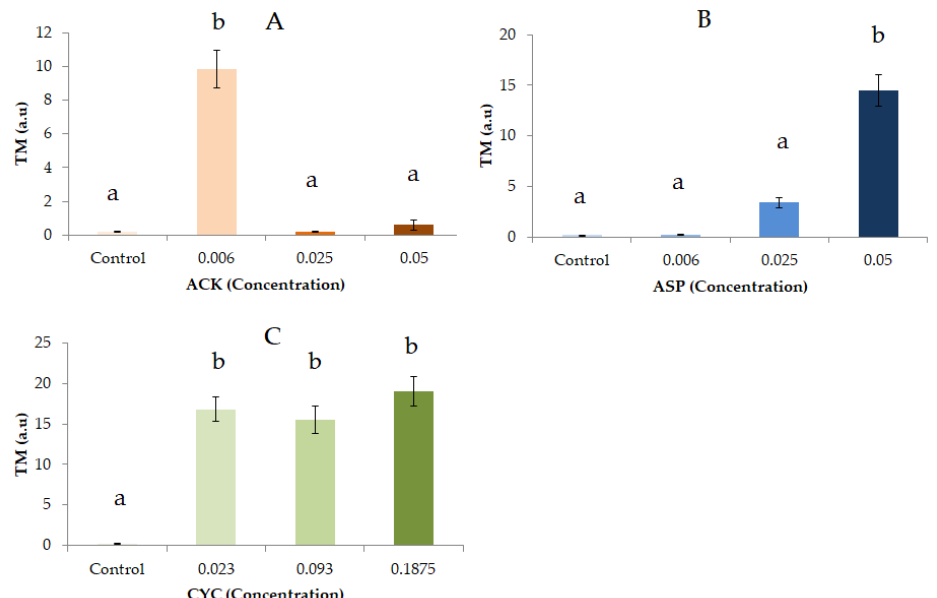
Figure 4. Alkaline comet assay (pH < 13) of HL-60 cells after 5 h-treatment with different concentrations of ACK ( A ), ASP ( B ) and CYC ( C ). DNA migration is reported as mean TM. The plot shows mean TM values and standard errors. Different letters mean different values after one-way ANOVA and post hoc Tukey’s test.